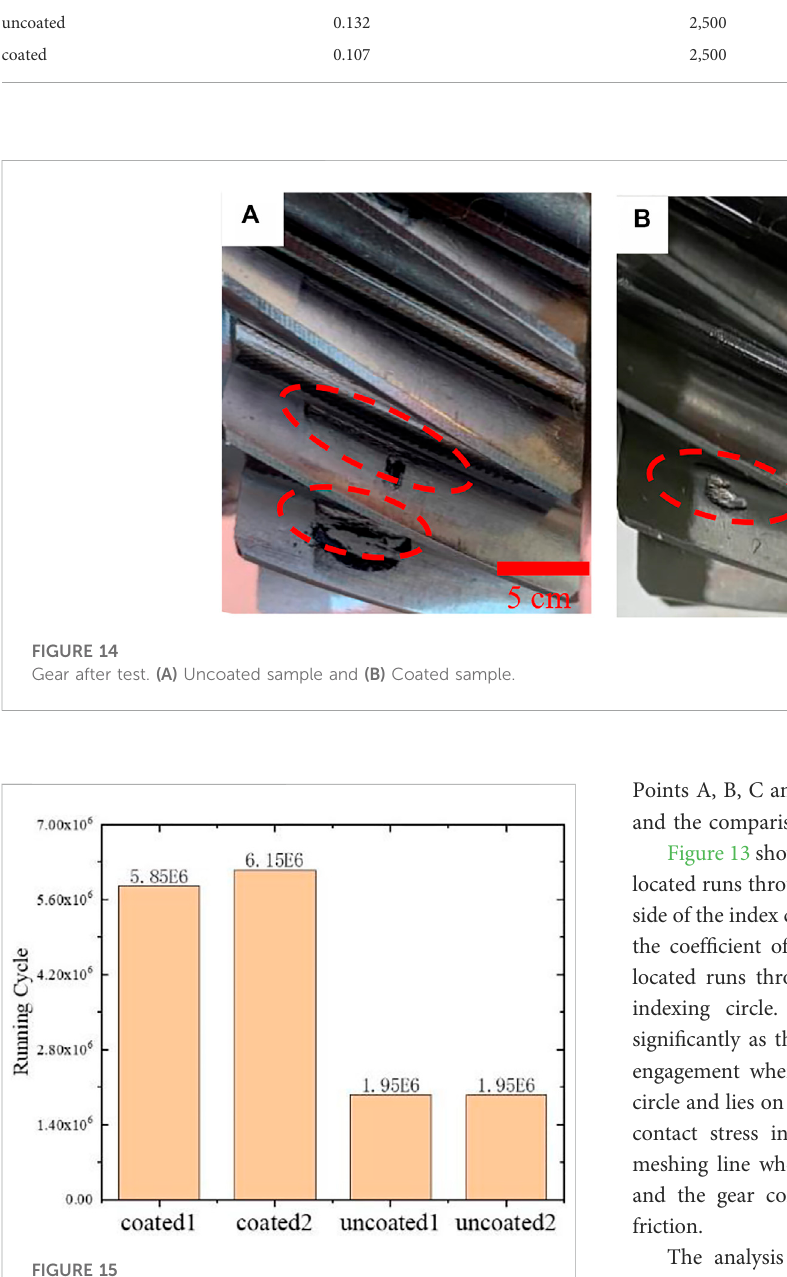
FIGURE 15 Histogram of gear fatigue